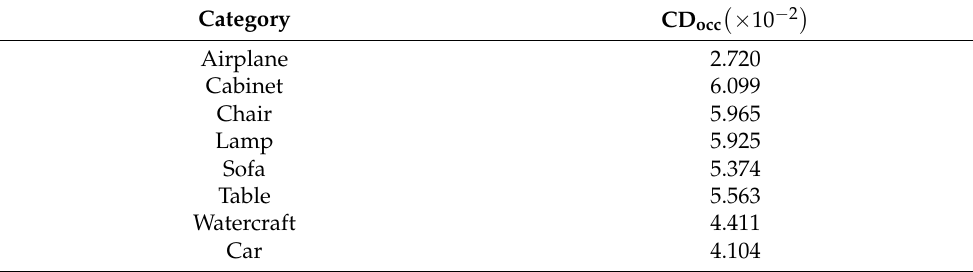
Table 3. The behavior of the network on different